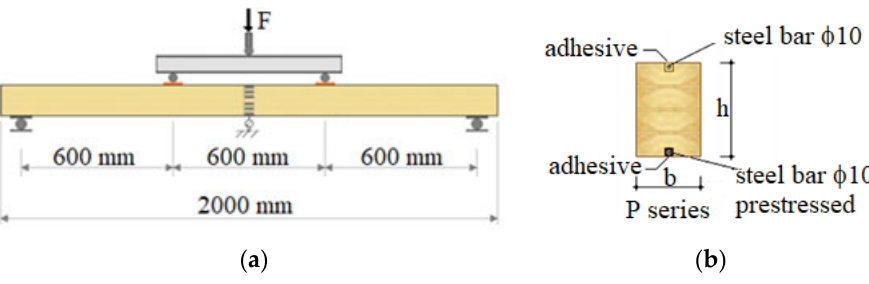
Figure 1. Considered dimensions in the: ( a ) four-point bending test; and ( b ) details of the cross-section with the inclusion of steel bars. Source: Adapted from Luca and Marano [14]. Reprinted/adapted with permission from Ref. 5344251152086.